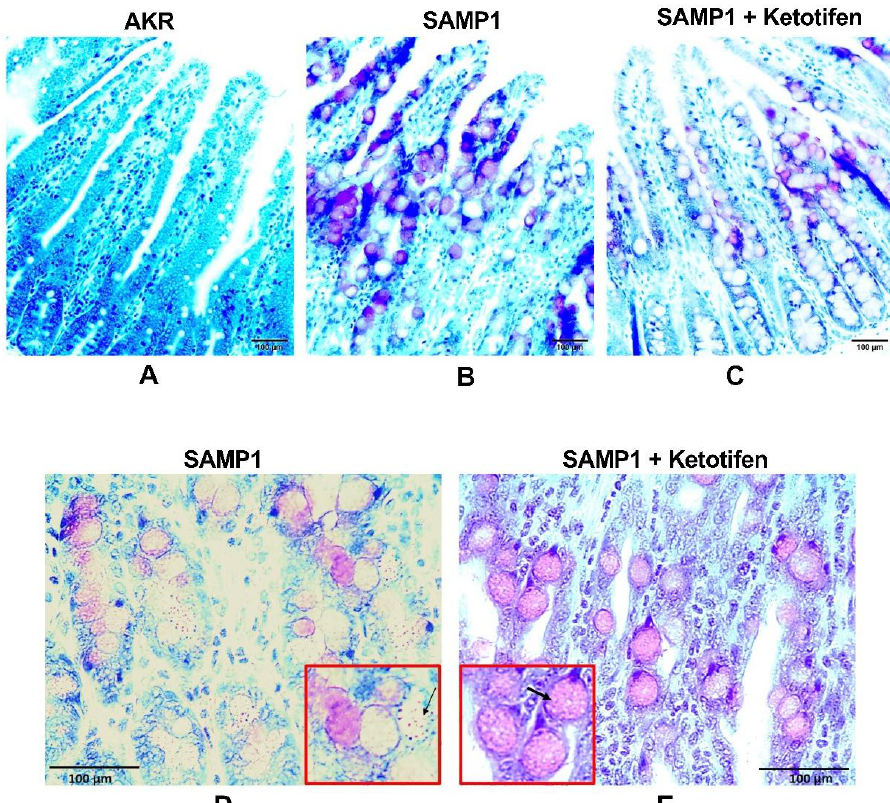
Figure 1. Effect of ketotifen on mast cell degranulation. Ileum of AKR ( A ), SAMP1 ( B ) and SAMP1 mice treated with ketotifen ( C ) were stained by toluidine blue. A marked increase in number of mast cells was observed by toluidine blue staining in SAMP1 mice (B,C). Original magnification 10×. Degranulation status of mast cell in SAMP1 ( D ) and SAMP1 mice treated with ketotifen ( E ) were observed in the presence of metachromatic blasts. Original magnification 40×. (D) In SAMP1 mice, degranulated mast cells were characterized by less intense metachromasia with free granules within the cytoplasm and outside of the cell border (indicated by thin black arrow). (E) In vivo treatment of SAMP1 mice with ketotifen prevented the degranulation of mast cells, which were round or oval with uniform color and intact cell membranes (indicated by bold black arrow).